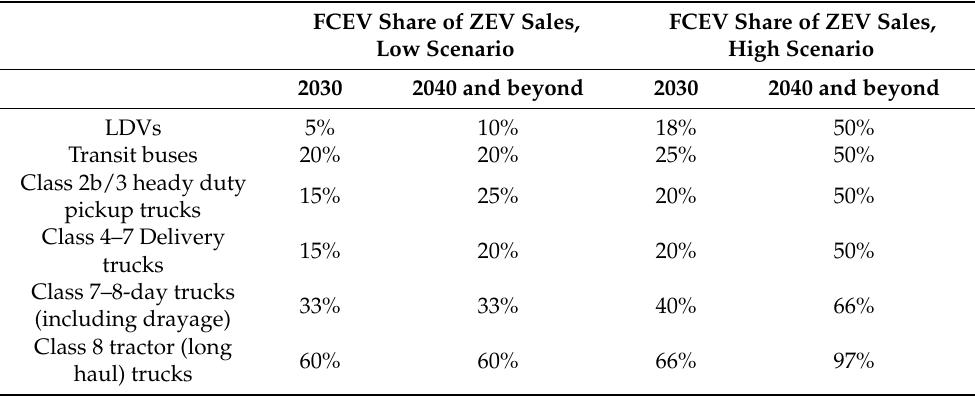
Table 2. FCEV share of ZEV sales in 2030 and beyond 2040 for high and low